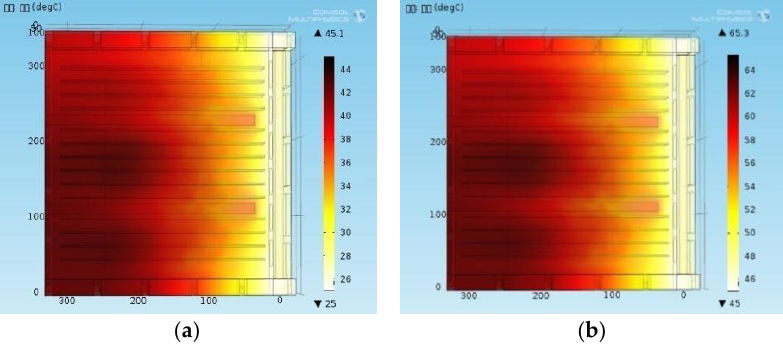
Figure 9. Finite-element analysis results: ( a ) in 25 degrees and ( b ) in 45 degrees.